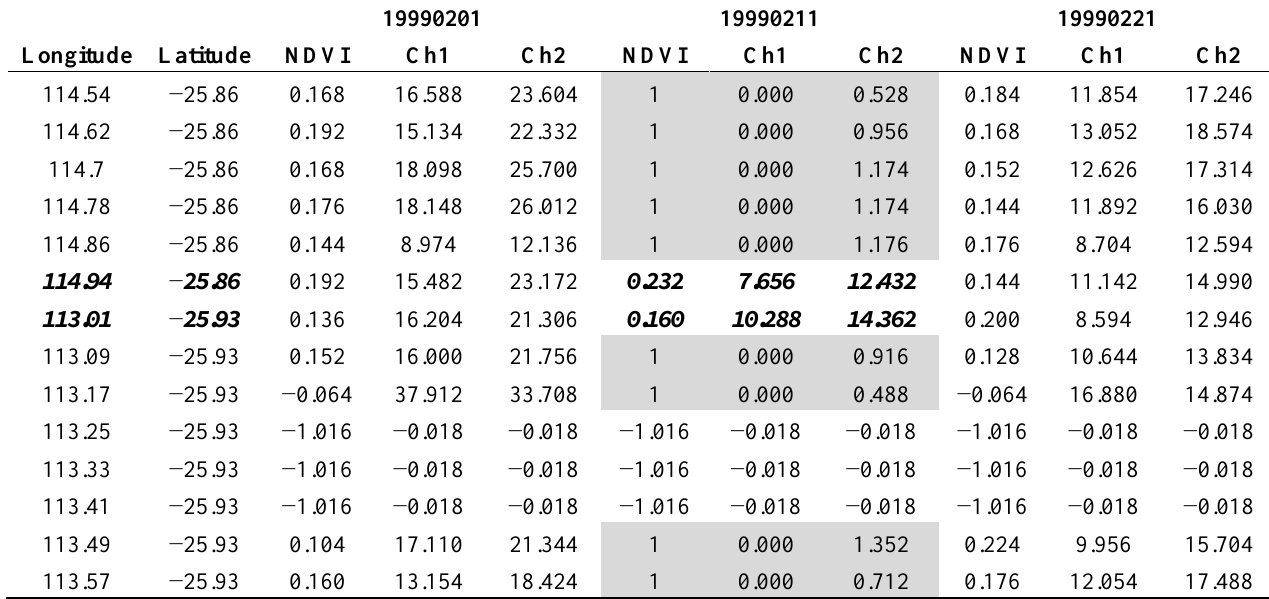
Table 2. A small subset extracted from the original 10-day composites of PAL NDVI, Channel 1 and Channel 2 for February 1999 (19990201: from 1 February to 10, 19990211: 11 to 20 and 19990221: 21 to 28): Shaded values present abnormally high NDVI and corresponding Channel 1 and Channel 2